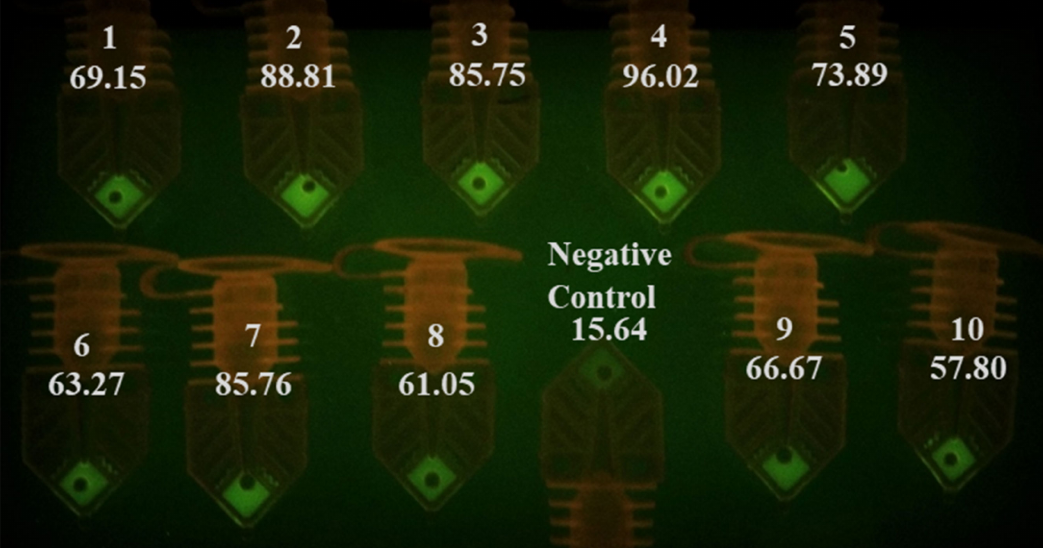
Figure 6. PCR Tubes after a RT-PCR run using 3 µ L of extracted templates. Ten out of ten samples can be identified as positive based on the fluorescence signal di ff erence when compared to the negative control. The RT-PCR run was completed in 12 min (90 s / 30 s / 40 × (6 s / 9 s)). The signal intensity measured by ImageJ is listed under the sample